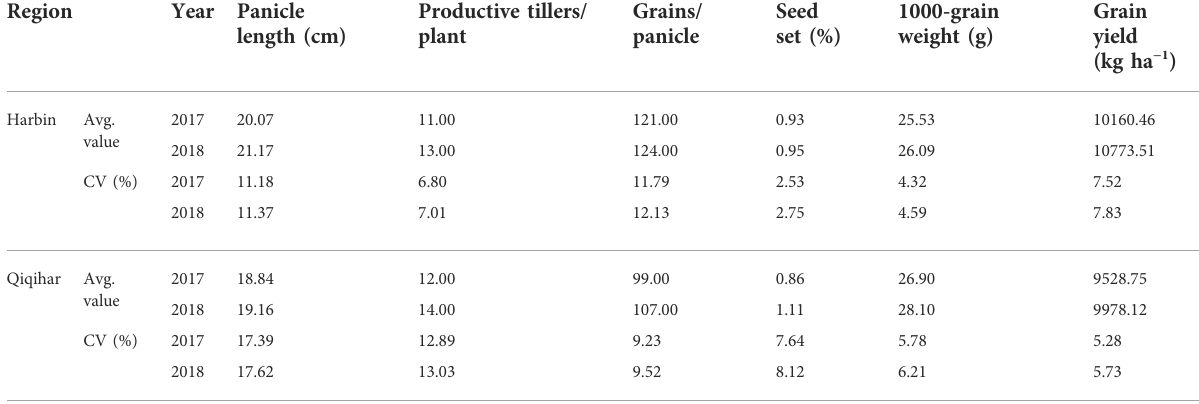
TABLE 5 Comparisons of rice grain yield and yield components under both climatic conditions.